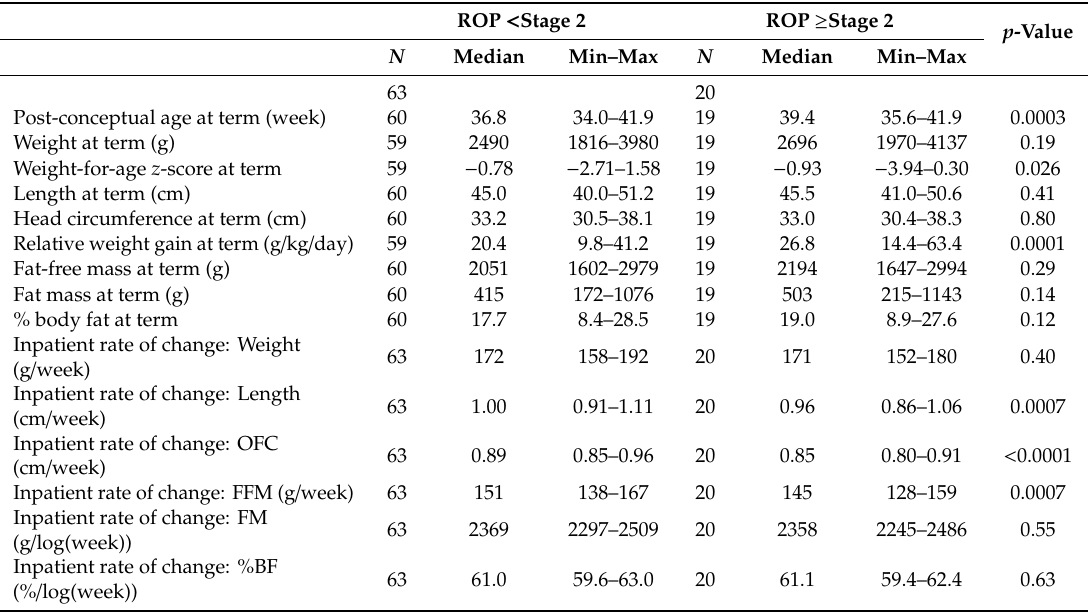
FFM = fat free mass. FM = fat mass. BF = body fat. ROP = retinopathy of